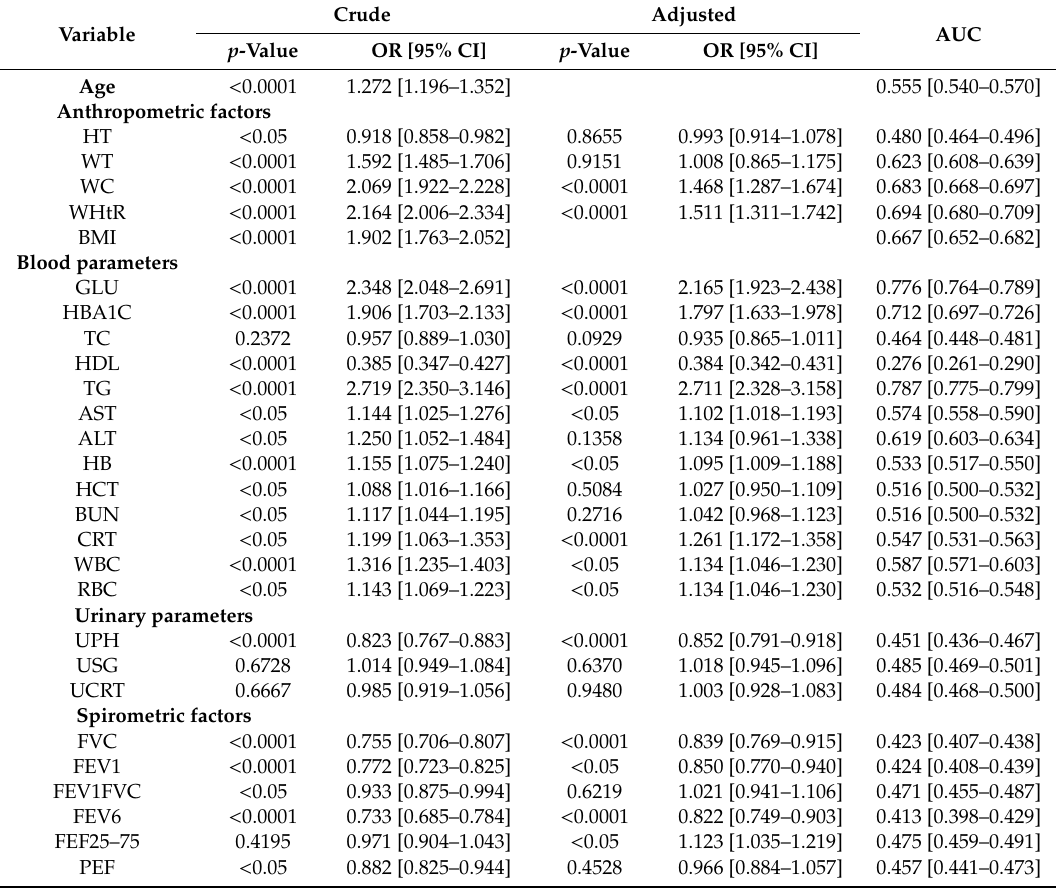
Table 3. Associations of anthropometric factors, blood parameters, urinary parameters, and spirometric factors with metabolic syndrome in